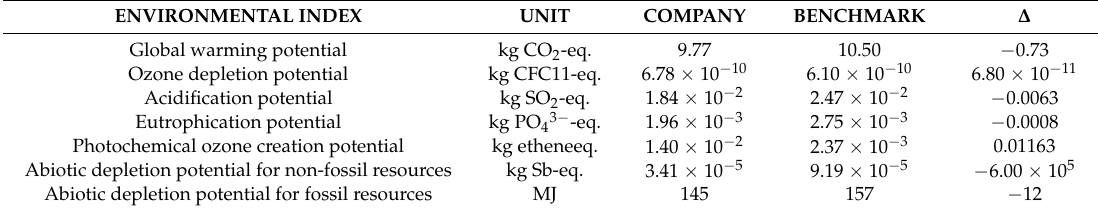
Table 2. Life Cycle Assessment results for 1 m 2 of ceramic